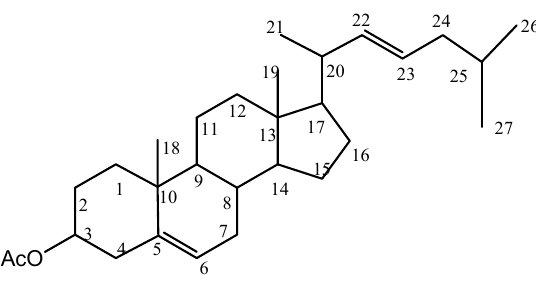
Figure 4. Structure of isolated compound 2 .